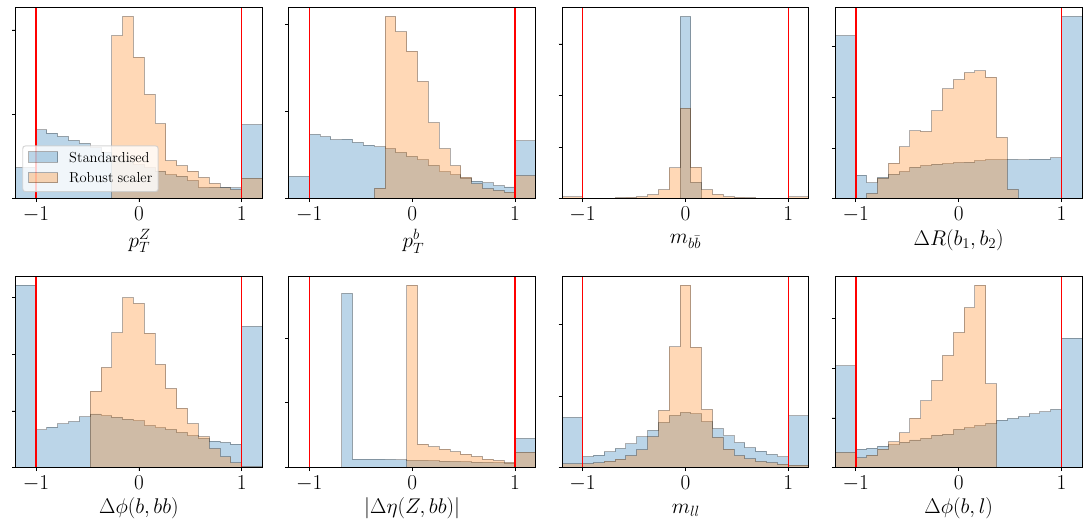
Figure 9. Comparison between two different data preprocessing schemes applied to the input features in the neural network training of the hZ → b ¯ b‘ + ‘ − likelihood: a Standardized Gaussian scaler and a robust scaler adopting a 95% inter-quantile